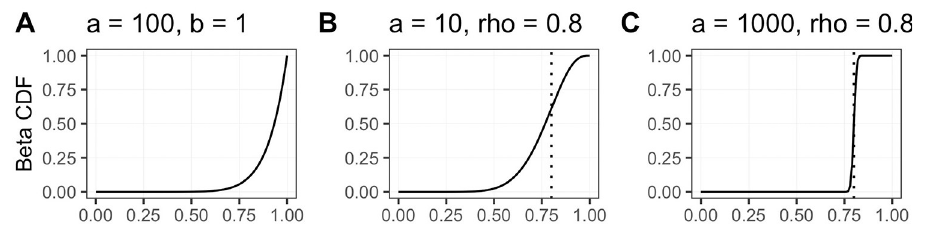
Fig 2. (A) The Beta distribution function with α = 100 and β = 1, (B) using the parameterization ρ = 0.8 with α = 10 we compute β = (10 − 1)(1 − 0.9)/0.9 − 1 = 2; the curve shows that the inflection point is at x = 0.8, (C) increasing α while keeping ρ constant has the effect of flattening the plateau; with α = 1000, we compute β = (1000 − 1)(1 − 0.9)/0.9 − 1 = 112, and the inflection points stays at x = ρ = 0.8. These curves illustrate the flexibility of using degree ranks along with the Beta distribution to control the preferential selection of high-degree nodes.